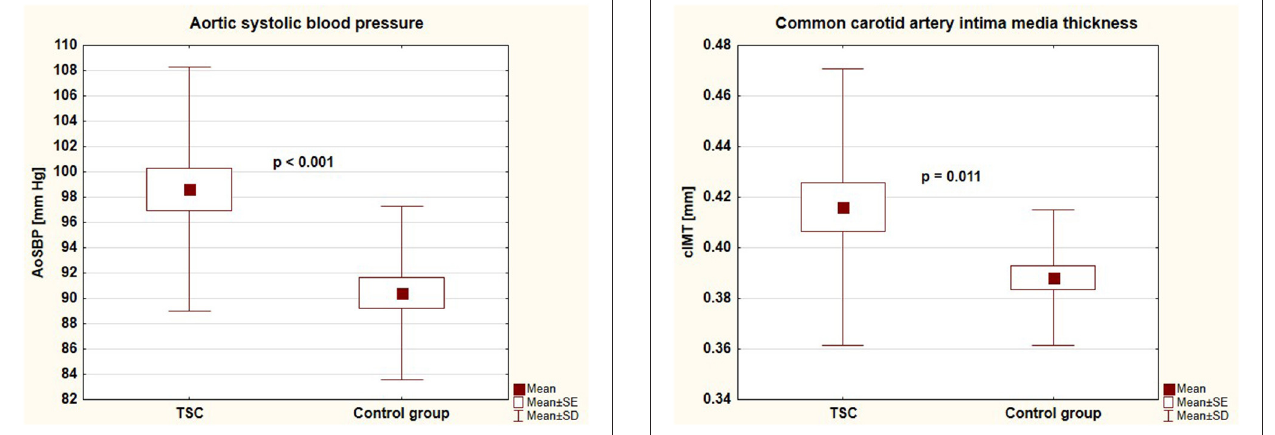
FIGURE 6 | Common carotid artery intima media thickness in children with tuberous sclerosis complex and in control group (cIMT, common carotid artery intima media thickness; TSC, tuberous sclerosis complex; SE, standard error; SD, standard